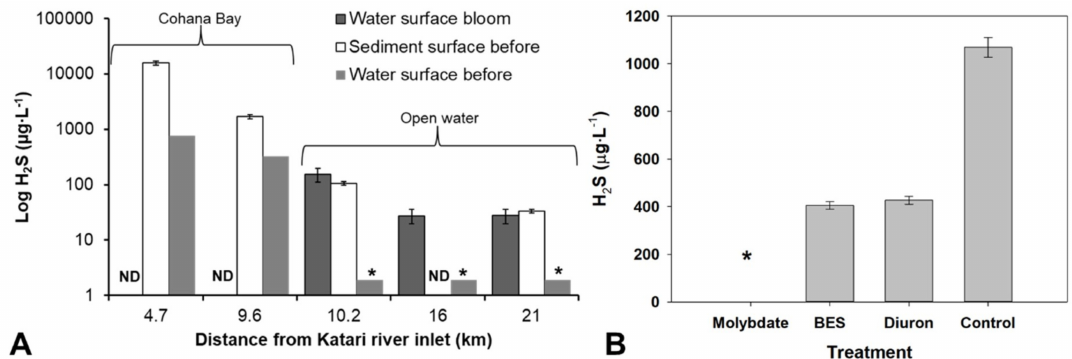
Figure 4. ( A ) Hydrogen sulfide concentrations in the water column along the transect from Katari river inlets in the sediment surface before the bloom and water surface before and after the bloom. Concentration in some locations was not determined (ND) or was below the detection limit (<1.9 µ g · L − 1 ) (*). ( B ) Hydrogen sulfide concentrations in pore water after incubations in samples at 9.6 km from the Katari River inlet amended with molybdate, BES (methanogen inhibitor), Diuron (algae inhibitor) compared to a not amended